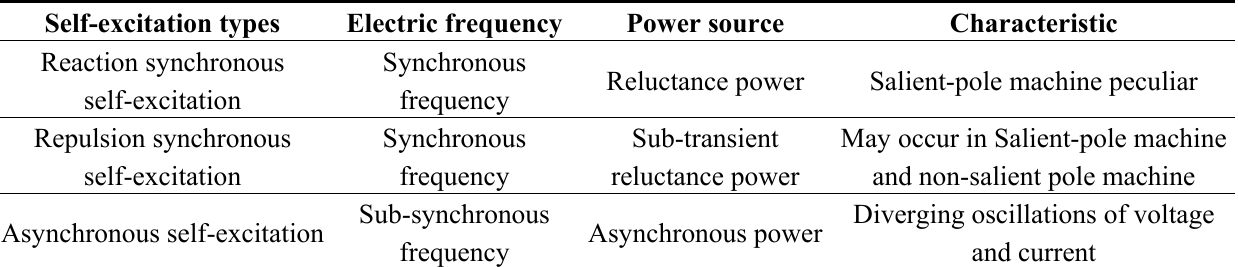
Table 1. Comparison of three self-excitation